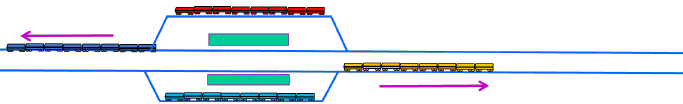
Figure 1. Double tracks as separate independent systems.